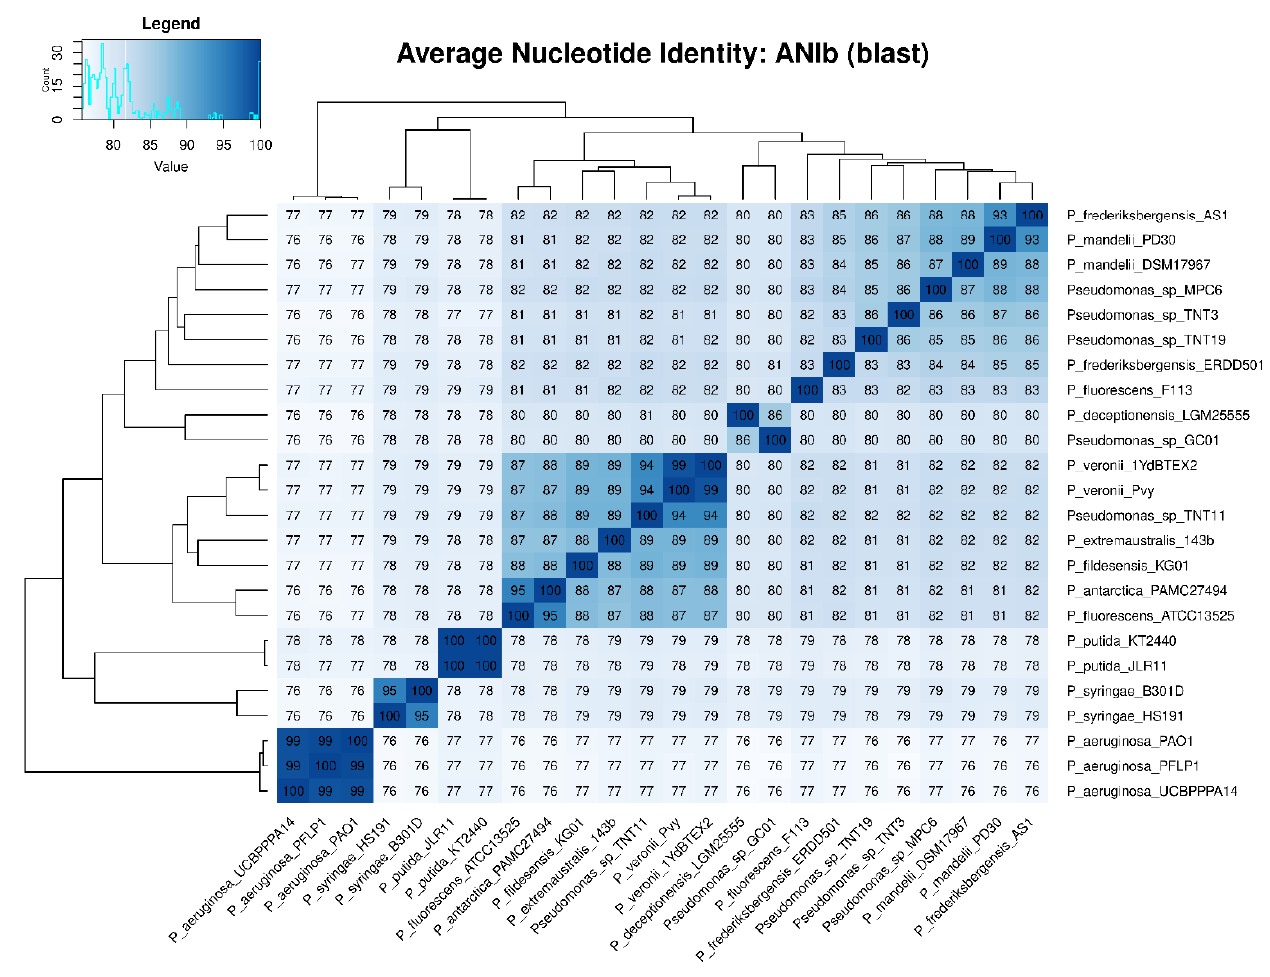
Figure 3. Average nucleotide identity (ANI) heat map based on BLASTn algorithm (ANIb) among the 24 pseudomonads used in this study. ANI values were calculated with PyANI after blastn alignment. Values are shown as percentages (%) of aligned nucleotides. ANI values above 95% between two genomes indicate that they belong to the same species.